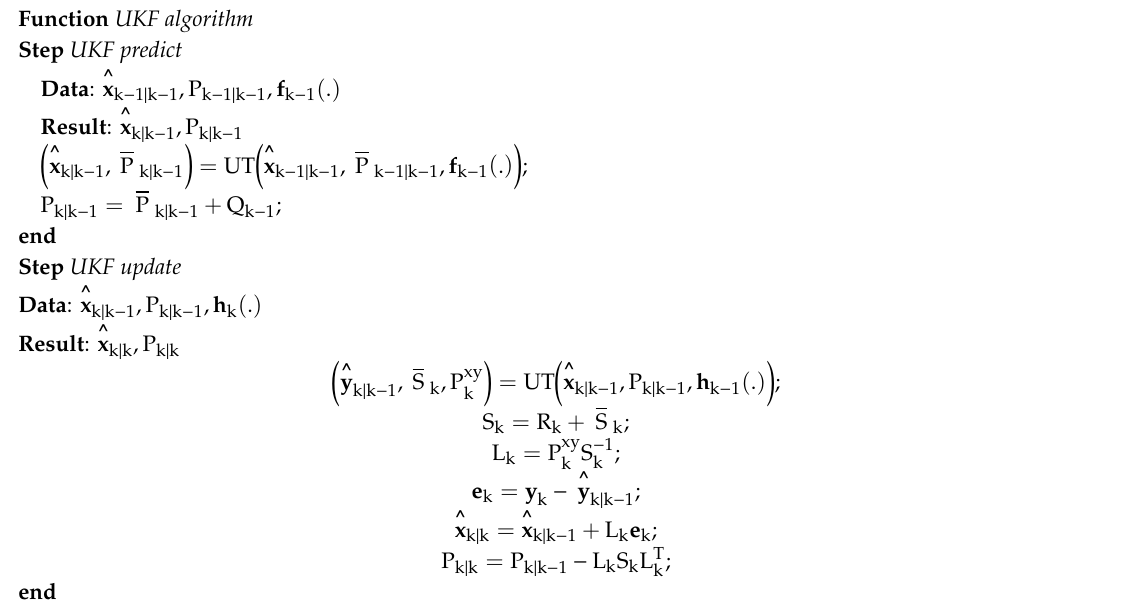
Algorithm 2. Navigation filter based on the unscented Kalman filter (UKF). Function UKF